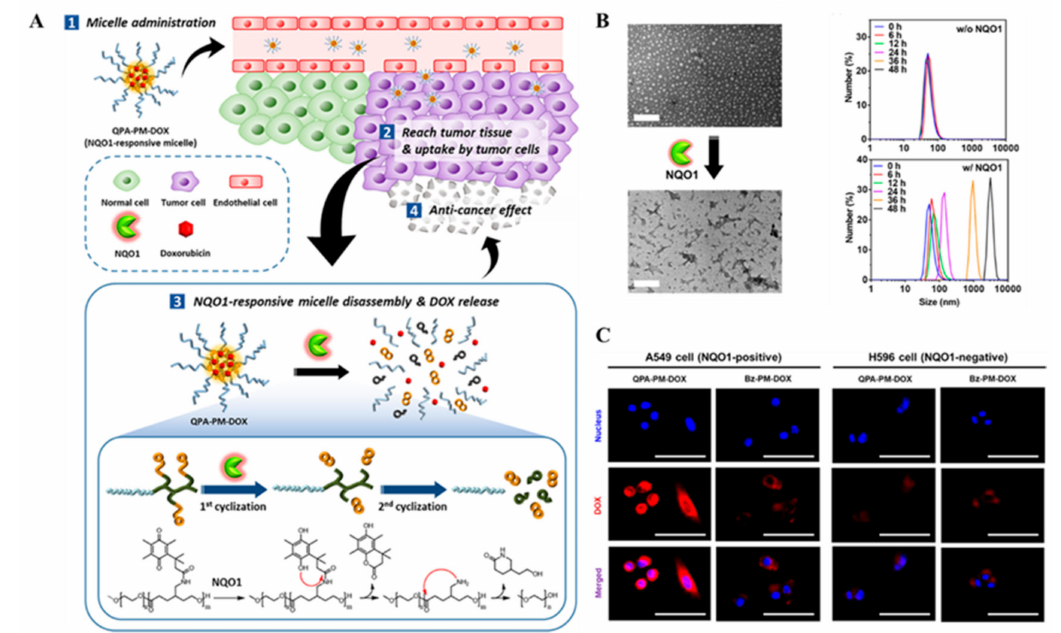
Figure 5. ( A ) Schematic representation of NQO1-responsive drug delivery system and drug release. ( B ) TEM images of the micelles after enzyme-mediated disassembly (scale bar: 200 nm) and time-dependent DLS size distribution of QPA-P micelles upon incubation with NQO1 enzymes. ( C ) Intracellular DOX release from QPA-PM-DOX and Bz-PMDOX in A549 (NQO1 positive) and H596 (NQO1 negative) observed by CLSM (scale bar: 50 µ m). Adapted from